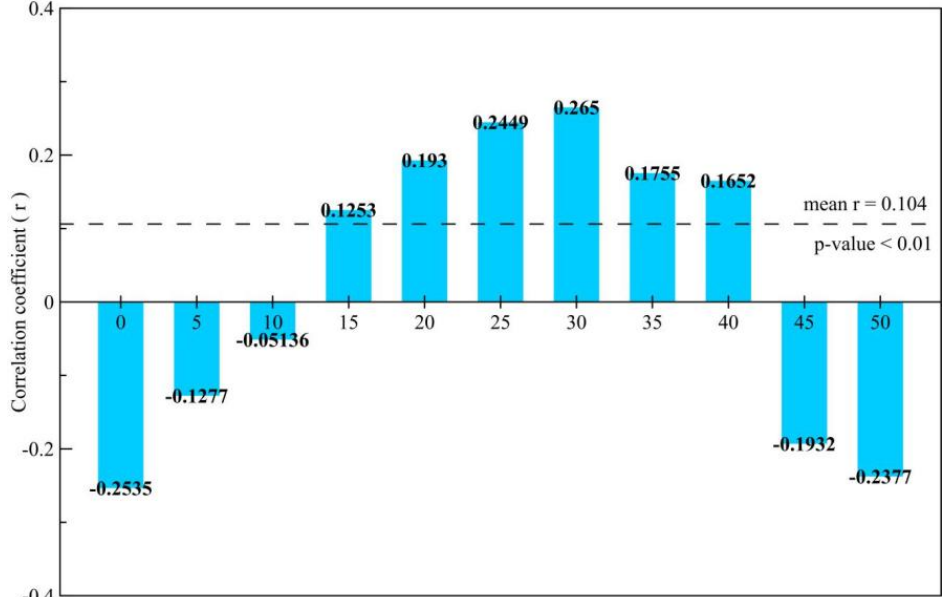
Figure 8. The histogram of correlation between M-scPDSI and B2000 with different lags lengths of time, M-scPDSI is short for the multidecadal component of our reconstructed scPDSI, and M-B2000 is short for the multidecadal component of B2000.